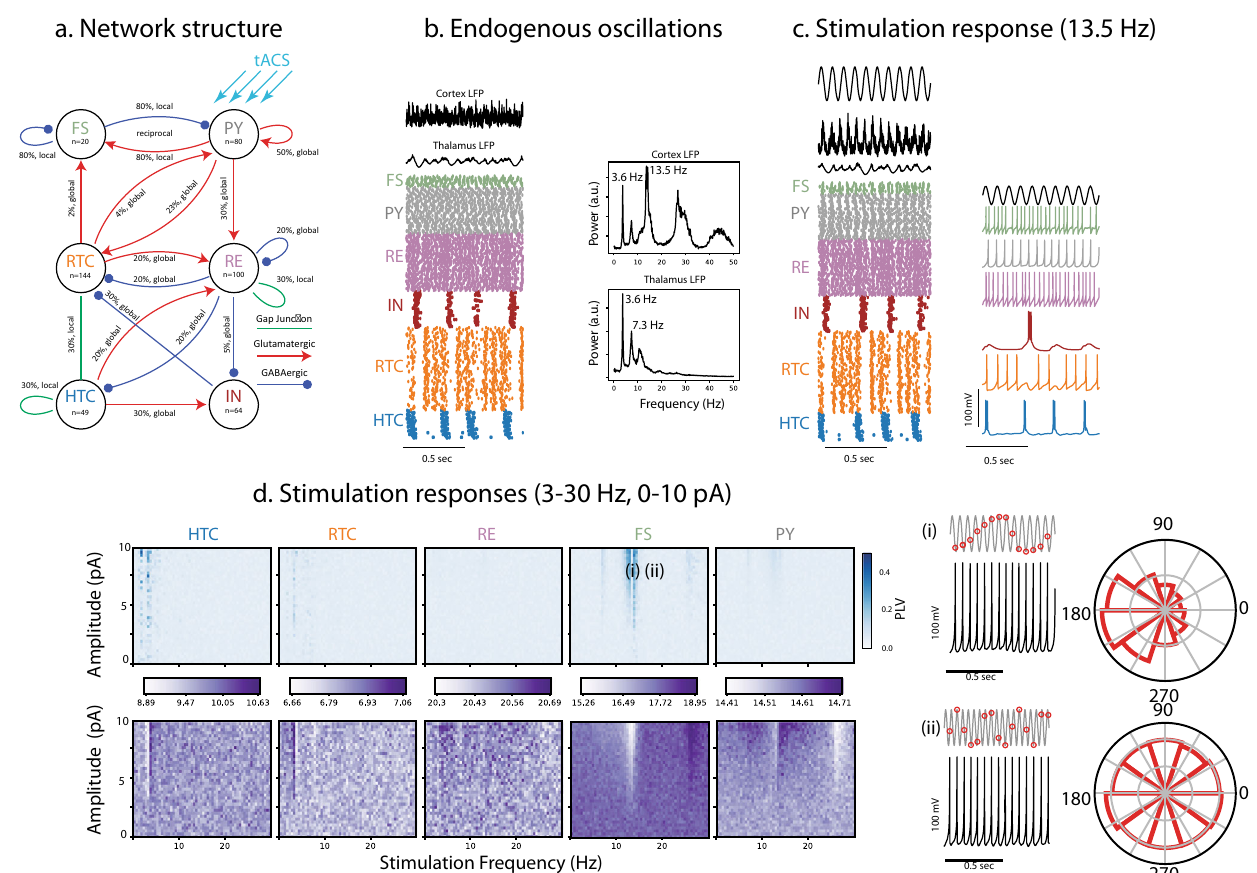
Fig. 6 Endogenous alpha oscillations in a thalamo-cortical model and synchronization by tACS. a The structure of the thalamo-cortical network with excitatory, inhibitory, and gap-junction connections between neuronal populations. The cortical network includes fast-spiking inhibitory (FS) and regular- spiking pyramidal (PY) neurons. The thalamic network includes relay thalamo-cortical (RTC), reticular (RE), high-threshold bursting (HTC), and thalamic local inhibitory (IN) neurons. The tACS is applied only to pyramidal neurons (blue arrows). b Endogenous oscillations shown by (top) 1-s cortical and thalamic local fi eld potential (LFP) traces, and (bottom left) the raster plot with each dot representing the fi ring instant of a neuron. (Bottom right) The cortical LFP has a dominant spectral peak at the alpha range (13.5 Hz), and a smaller peak at theta range (3.6 Hz). The thalamic LFP has a dominant theta peak (3.6 Hz), its harmonic (7.3 Hz), and a weak alpha peak (13.5 Hz). c Network response to a 13.5 Hz, 8 pA tACS. The cortical and thalamic LFP traces, and the raster plot showing the fi ring of all neurons (left), and the membrane voltage traces of sample neuron from each cell type (right). d Network response to a group of stimuli with frequencies between 3 and 30 Hz, and amplitudes between 0 and 10 pA. Top left heat-maps: The color-coded phase- locking value (PLV) as a function of stimulation frequency (horizontal axis), and stimulation amplitude (vertical axis) for each neuron type. Darker colors indicate higher synchronization between individual neurons and tACS with corresponding frequency and amplitude. The FS and PY neurons show triangular-shape high PLV regions centered on the alpha peak frequency (13.5 Hz). Bottom left heat-maps: The fi ring rate (FR) maps for each neuron type. The color at each point indicates the average fi ring rate (in Hz) across neurons in response to tACS with corresponding frequency (horizontal axis) and amplitude (vertical axis). Two points on PLV and FR maps are selected for further analysis: (i) A point with high PLV on Arnold tongue region with tACS parameters of 13.5 Hz and 8 pA. The tACS waveform and membrane potential of a sample PY neuron (top right) show that the PY neuron fi res regularly after the peak of the tACS wave (red circles). The phase distribution of tACS wave at fi ring instances of PY neuron shows a phase preference between 90 and 180 degrees. (ii) A point with low PLV outside of the Arnold tongue region with tACS parameters of 18.5 Hz and 8 pA. The tACS waveform and membrane potential of a sample PY neuron (bottom right) show that the PY neuron fi res at random phases of tACS wave (red circles). The phase distribution of the tACS waveform when PY neurons fi red shows a uniform phase